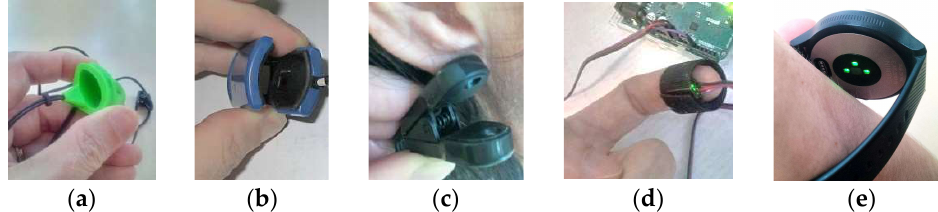
Figure 2. Examples of practical realizations of optical parts of a PPG sensor: ( a ) rubber finger ring [21], ( b ) plastic finger clip [20], ( c ) plastic ear clip [22], ( d ) reflectance PPG sensor with analogue interface fixed on an index finger by an elastic ribbon, ( e ) back side of the Garmin watch VivoActive 3 with three green LEDs and one PD inside—loosely put on a wrist [23].